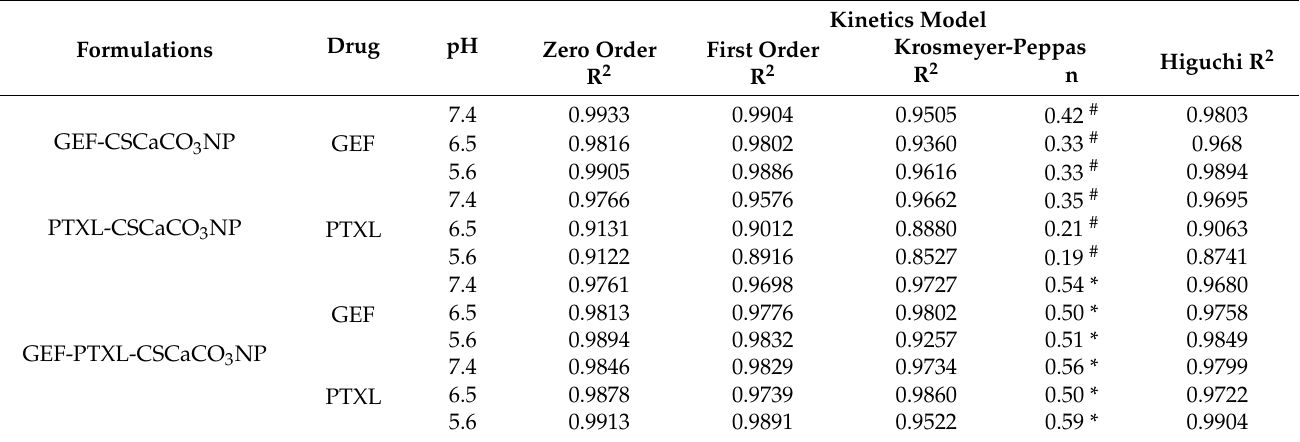
Table 4. Correlation coefficients R 2 for GEF, PTXL, and GEF-PTXL derived from various kinetics models and the n value for the Krosmeyer-Peppas model in PBS with 0.2% ( v / v ) Tween 80 at pH of 5.6, 6.5, and 7.4.